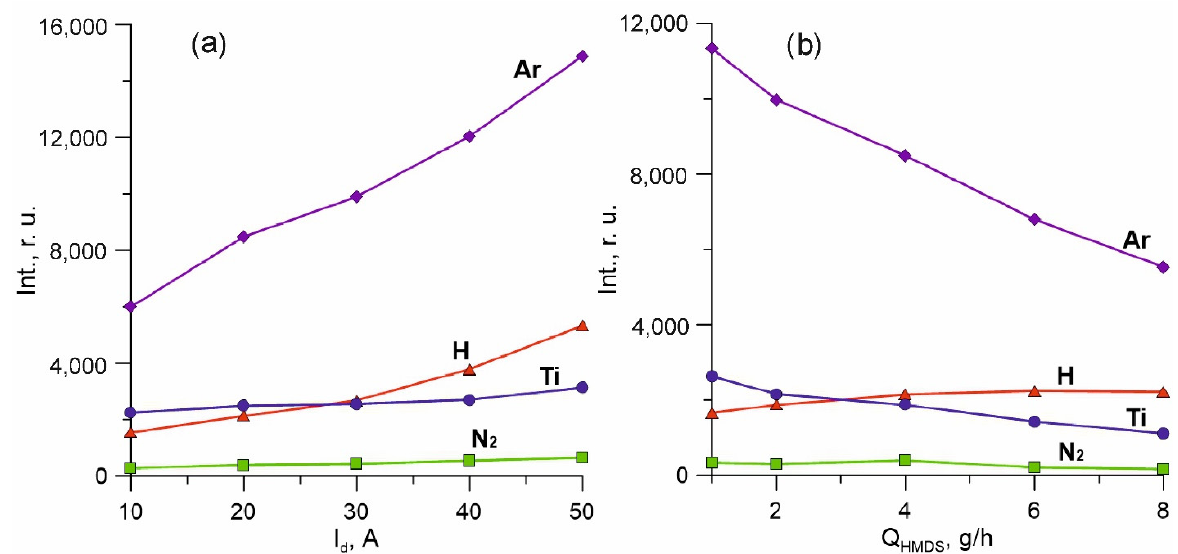
Figure 4. The dependences of the intensities of the spectral lines Ar (811.5 nm), Ti (453.3 nm), N 2 (337.1 nm) and H (656.3 nm) on the discharge current I d ( a ) and on the Q HMDS flow ( b ). I cr = 2 A, Q Ar = 100 sccm, Q N2 = 10 sccm. (a)— Q HMDS = 4 g/h, (b)— I d = 20 A. At the same time, the increase in the vapour flow from 1 to 8 g/h at a direct current of discharge does not lead to an increase in the intensity of line H. This indicates a decrease